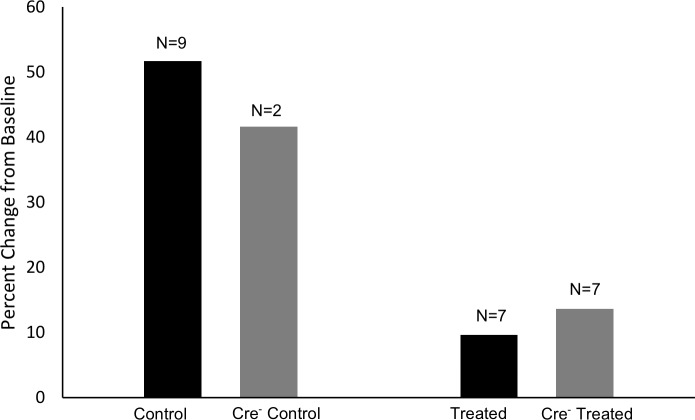
Pilot data on the effect of 3 months administration of doxycycline.Compared to baseline, male mice with (treated) and without (Cre- treated) the Cre insertion that received DOX in the chow experienced a reduction in fat mass compared to baseline. By contrast, both mice positive (control) and negative (Cre-) for Cre that did not receive DOX exhibited a 40–50% increase in fat mass compared to baseline.